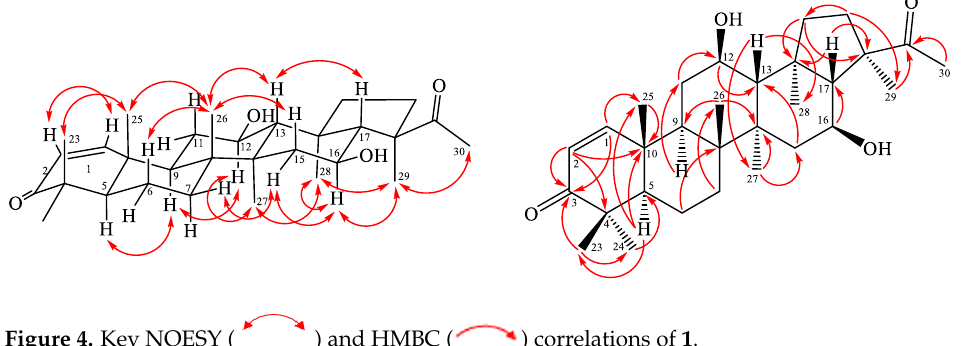
Figure 4. Key NOESY ( ) and HMBC ( ) correlations of 1 .